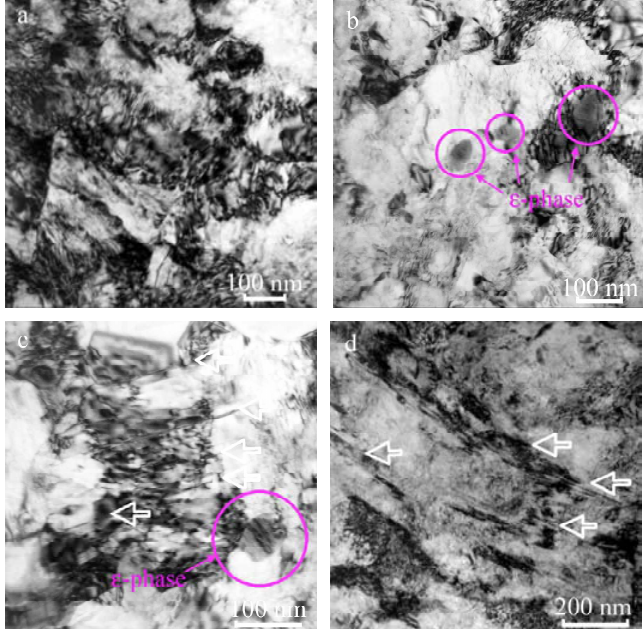
Fig. 6. Details of the microstructure in UFG-CrNiMo steel specimens: a – after ABC-pressing; b – after ABC-pressing and H-charging for 65 hours; c – after ABC-pressing, H-charging for 65 hours and tension; d – after ABC-pressing, H-charging for 100 hours and tension. Arrows on images (c) and (d) show mechanical twins. All images correspond to surface hydrogen-saturated